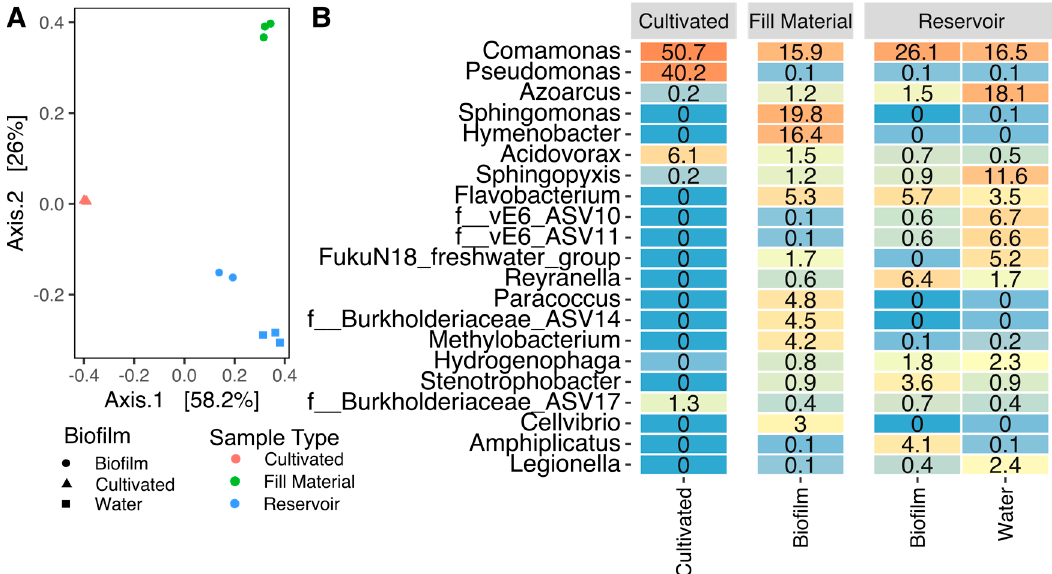
Figure 3. ( A ): Principal Coordinates Analysis based on Bray–Curtis distances between ASV relative abundances. The two most significant principal components are shown, axes annotated with percentage of variation explained. ( B ): Heatmap showing mean percentage abundances for all sample types for the 21 most abundant genera in the dataset. Rows labeled with names ending in “_ASVXX” show ASVs with undefined genera (only defined up to the family level) which are nonetheless more abundant than all genera in the top 21. vE6 is an uncultured family-level group within the